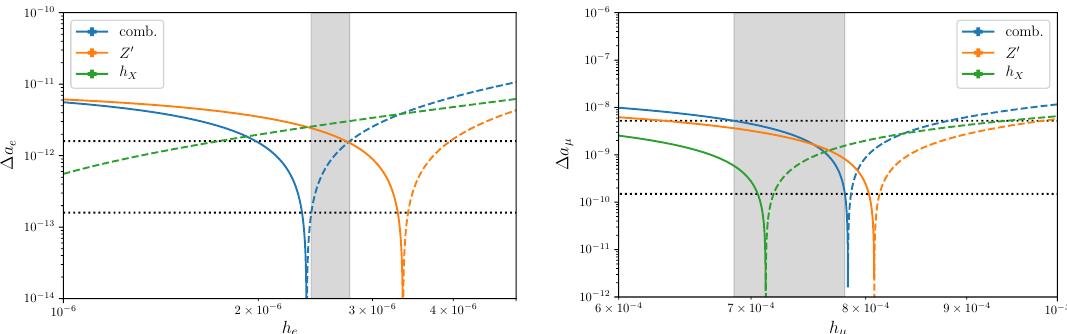
Figure 4 . Contributions to the anomalous magnetic moment of charged leptons, j (cid:1) a ‘ j , as a function of the h ‘ coupling for ‘ = e (left) and ‘ = (cid:22) (right). Solid (dashed) lines correspond to positive (negative) values of (cid:1) a ‘ ; the colour code denotes contributions from the Z 0 (orange) and from h X (green), as well as the combined one (blue). Horizontal (dotted) lines denote the 2 (cid:27) and 3 (cid:27) regions of the electron and muon (cid:1) a ‘ . A vertical opaque region corresponds to the h ‘ interval for which the combined contributions to (cid:1) a lie within the 2 (cid:27) (3 (cid:27) ) region. Leading to this (cid:12)gure, e ( (cid:22) ) we have selected a benchmark choice of parameters complying with all the constraints mentioned in section 5: M L = M E = 90 GeV, (cid:21) E = (cid:21) L = M L =v X , m h = 70 GeV, " = (cid:0) 8 (cid:2) 10 (cid:0) 4 , " B (cid:0) L = 0 : 002 X and k ‘ = 10 (cid:0) 7